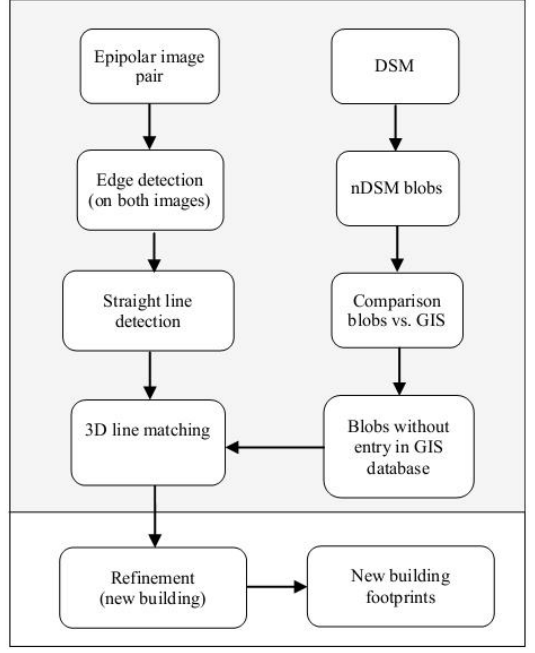
Figure 1. Diagram for detection of footprints of new